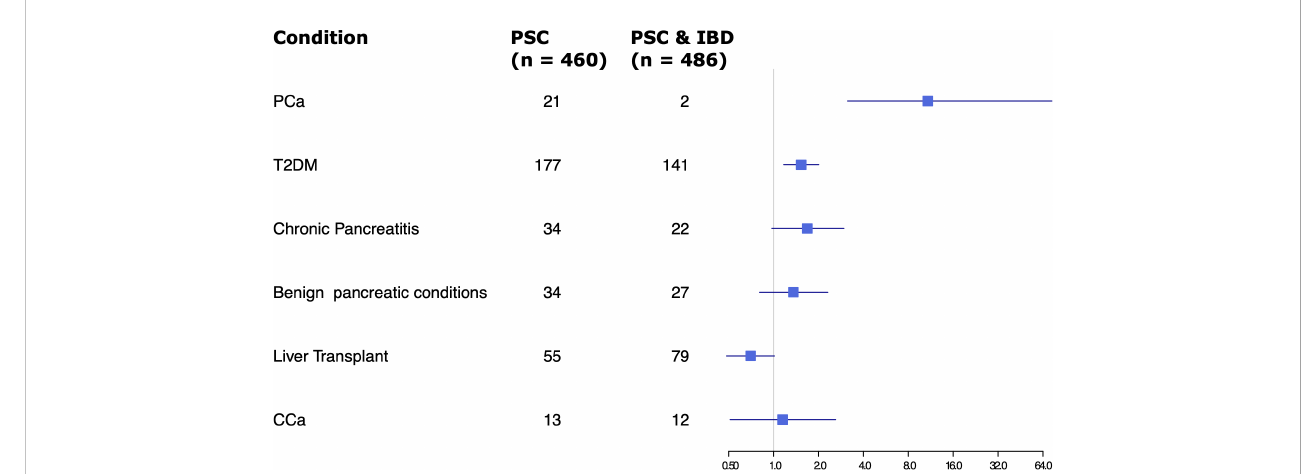
FIGURE 2 Forest plot of odds ratios for various factors assessed in patients with PSC only vs PSC and IBD.